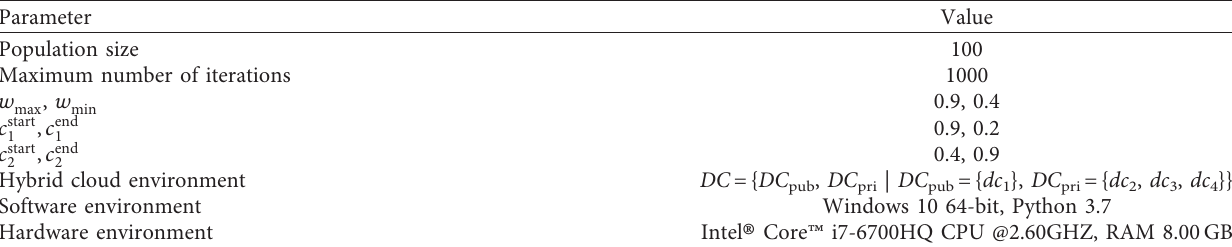
Table 1: Environment and parameter